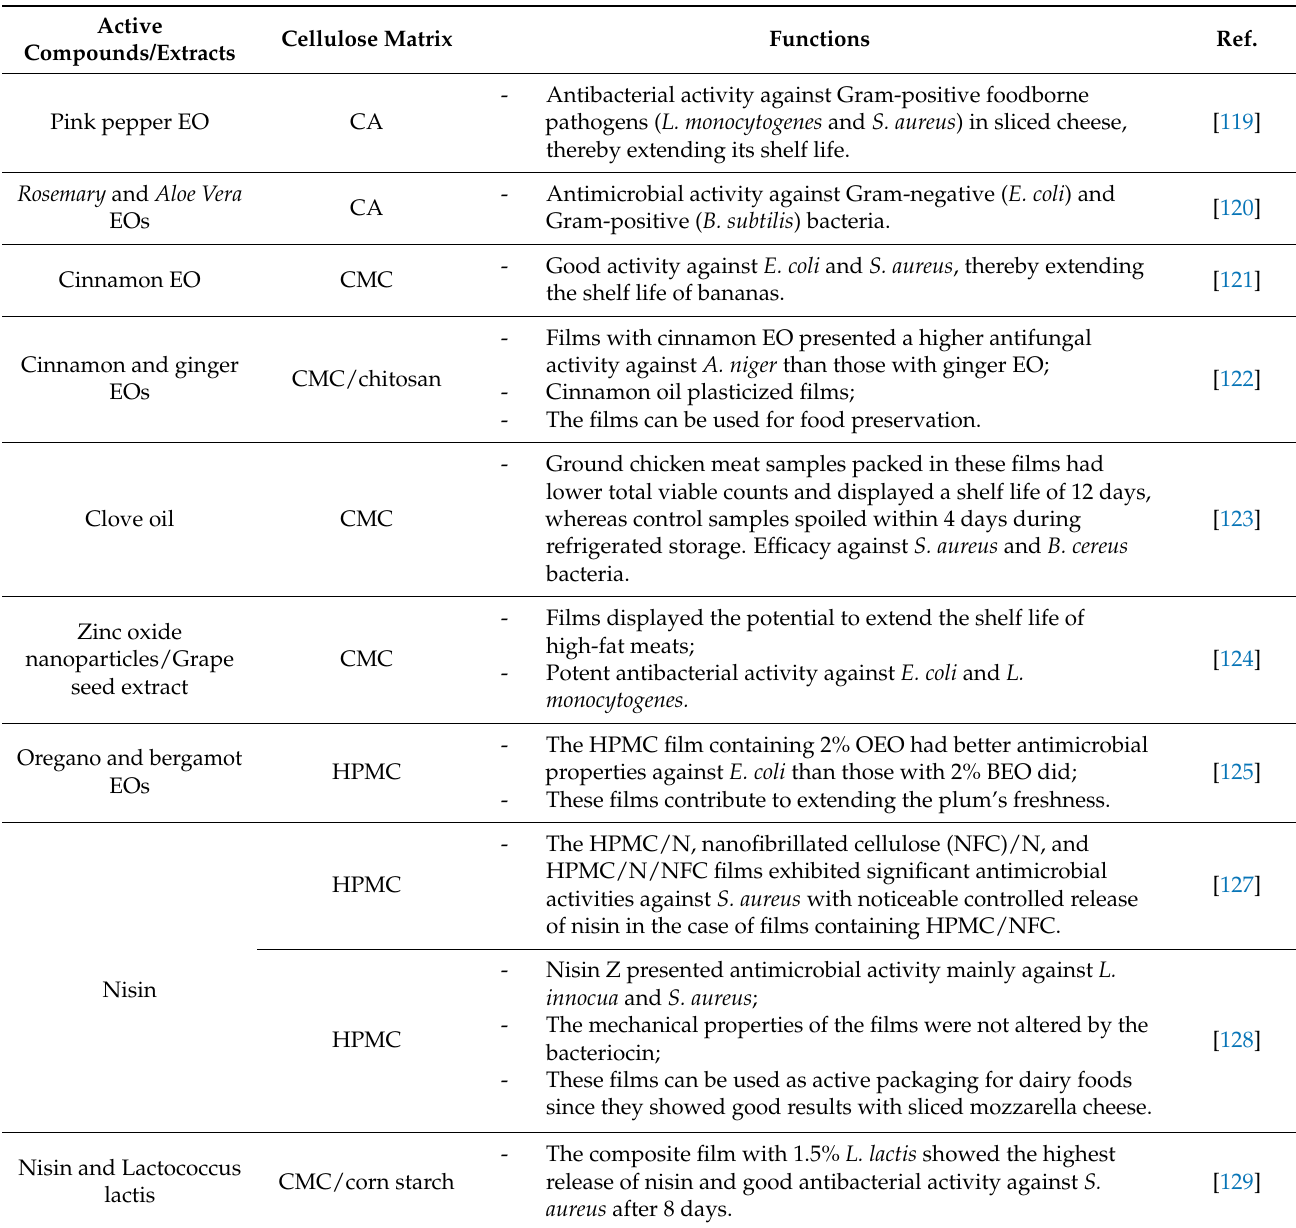
Table 1. Summary of antimicrobial cellulose films functionalized with active compounds/extracts, showing beneficial properties for food